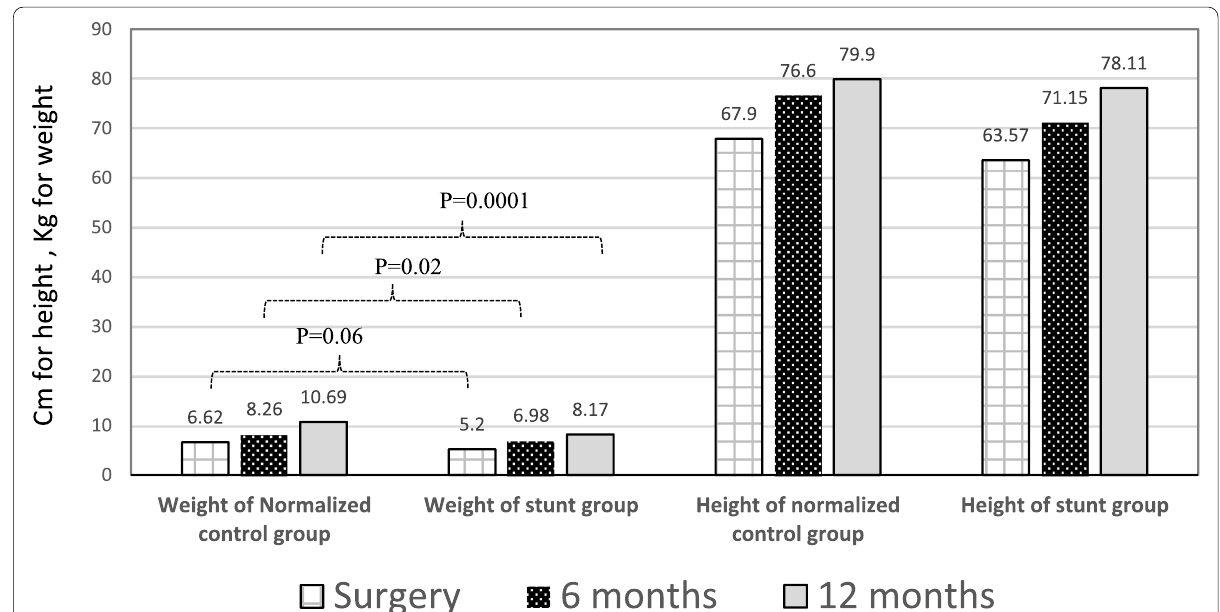
Fig. 2 Weight and height for normalized control group and underweight group at surgery, 6 months, and 1 month follow-up